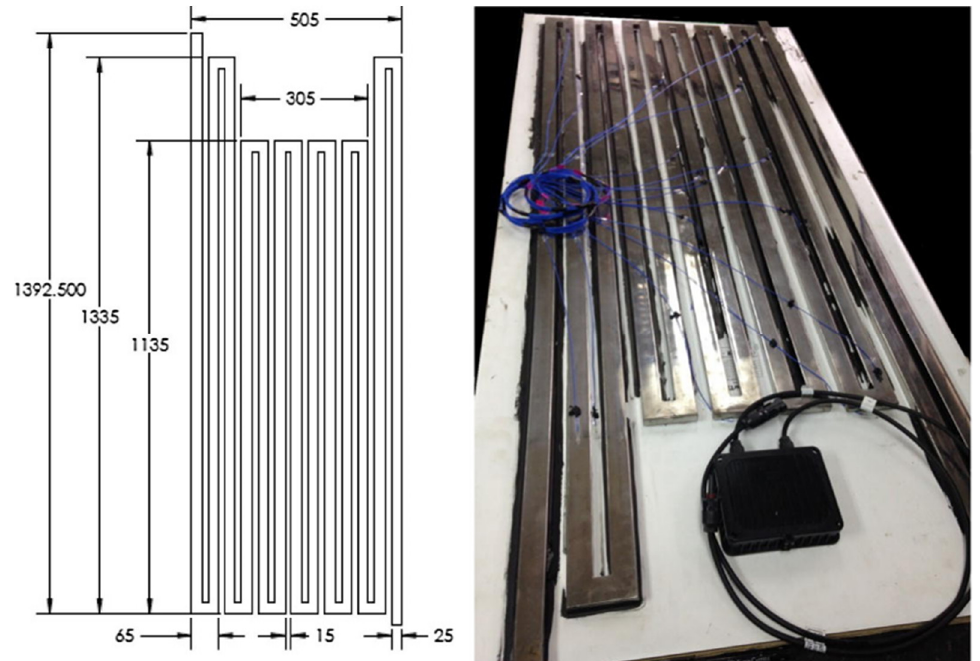
Figure 13. Proposed stainless steel PVT collector design. Reprinted with permission from Ref. [114]. 2016. Al-Shamani et al.